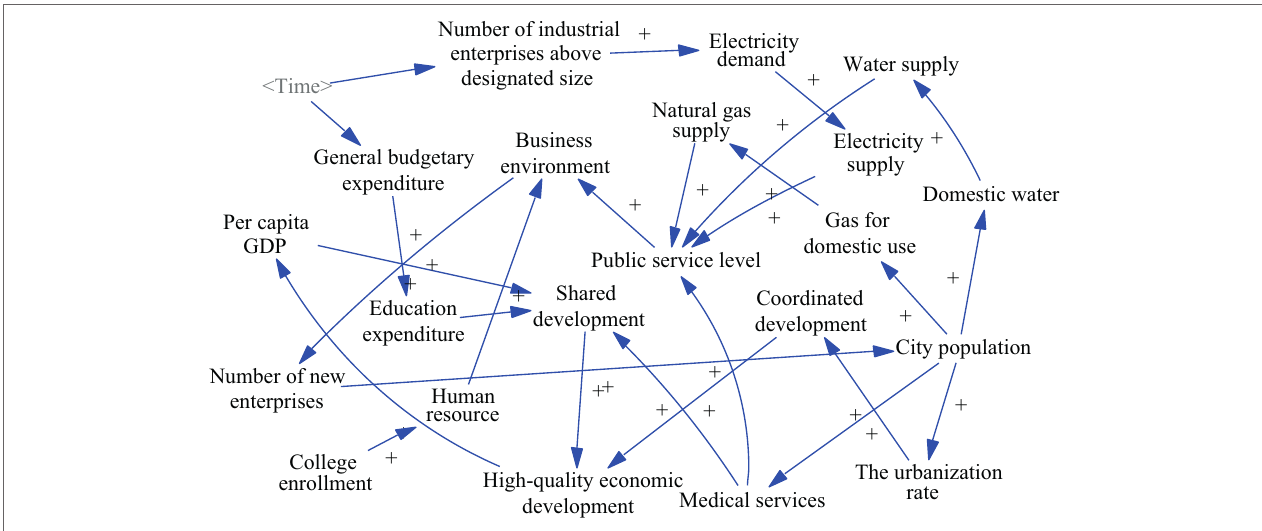
FIGURE 3 | Public development sub-system causality